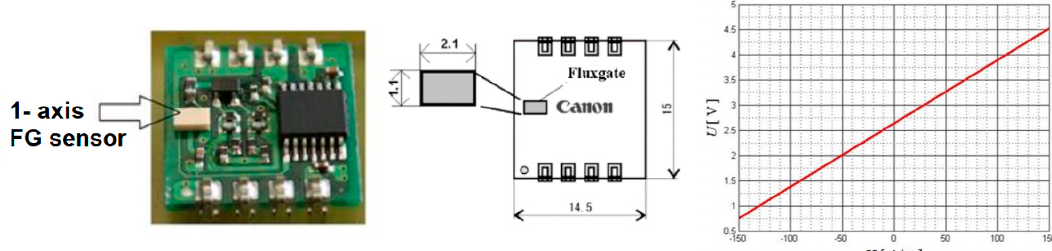
Figure 1. Fluxgate sensor used in measurements with its calibration curve.